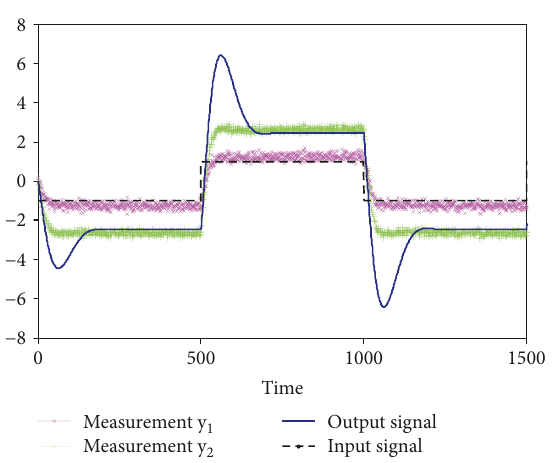
Figure 7: The estimate error of x ( L =200).